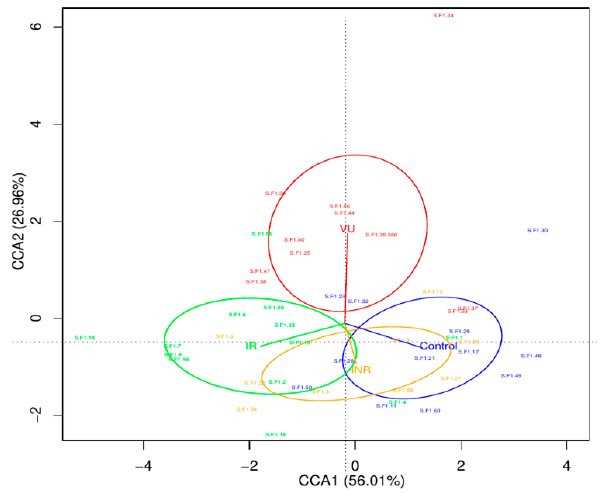
Figure 2. Canonical correspondence analysis (CCA) based on operational taxonomic unit (OTU) abundance. INR, immunological ART non-responders (yellow); IR, immunological ART responders (green); VU, viremic untreated (red); and controls (blue).